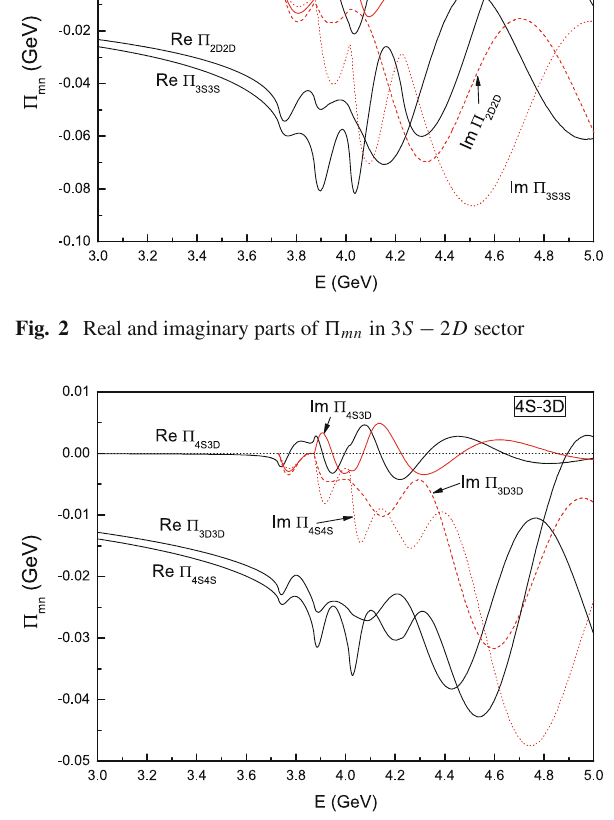
Fig. 3 Real and imaginary parts of (cid:6) mn in 4 S − 3 D